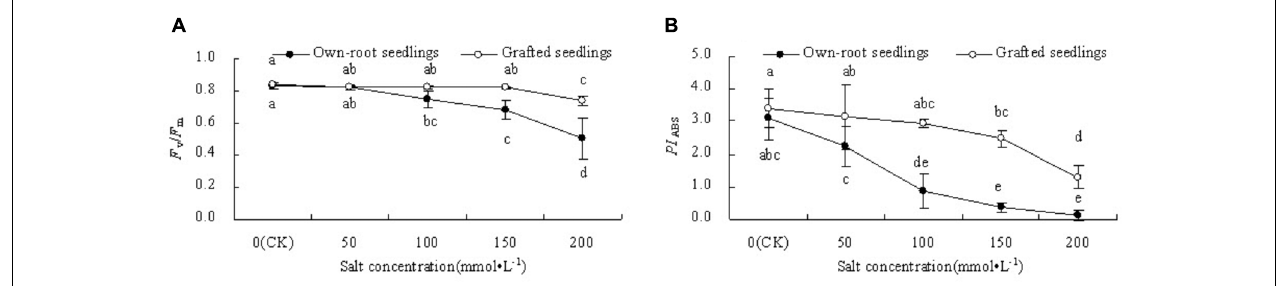
salt stress increased to different degrees compared with